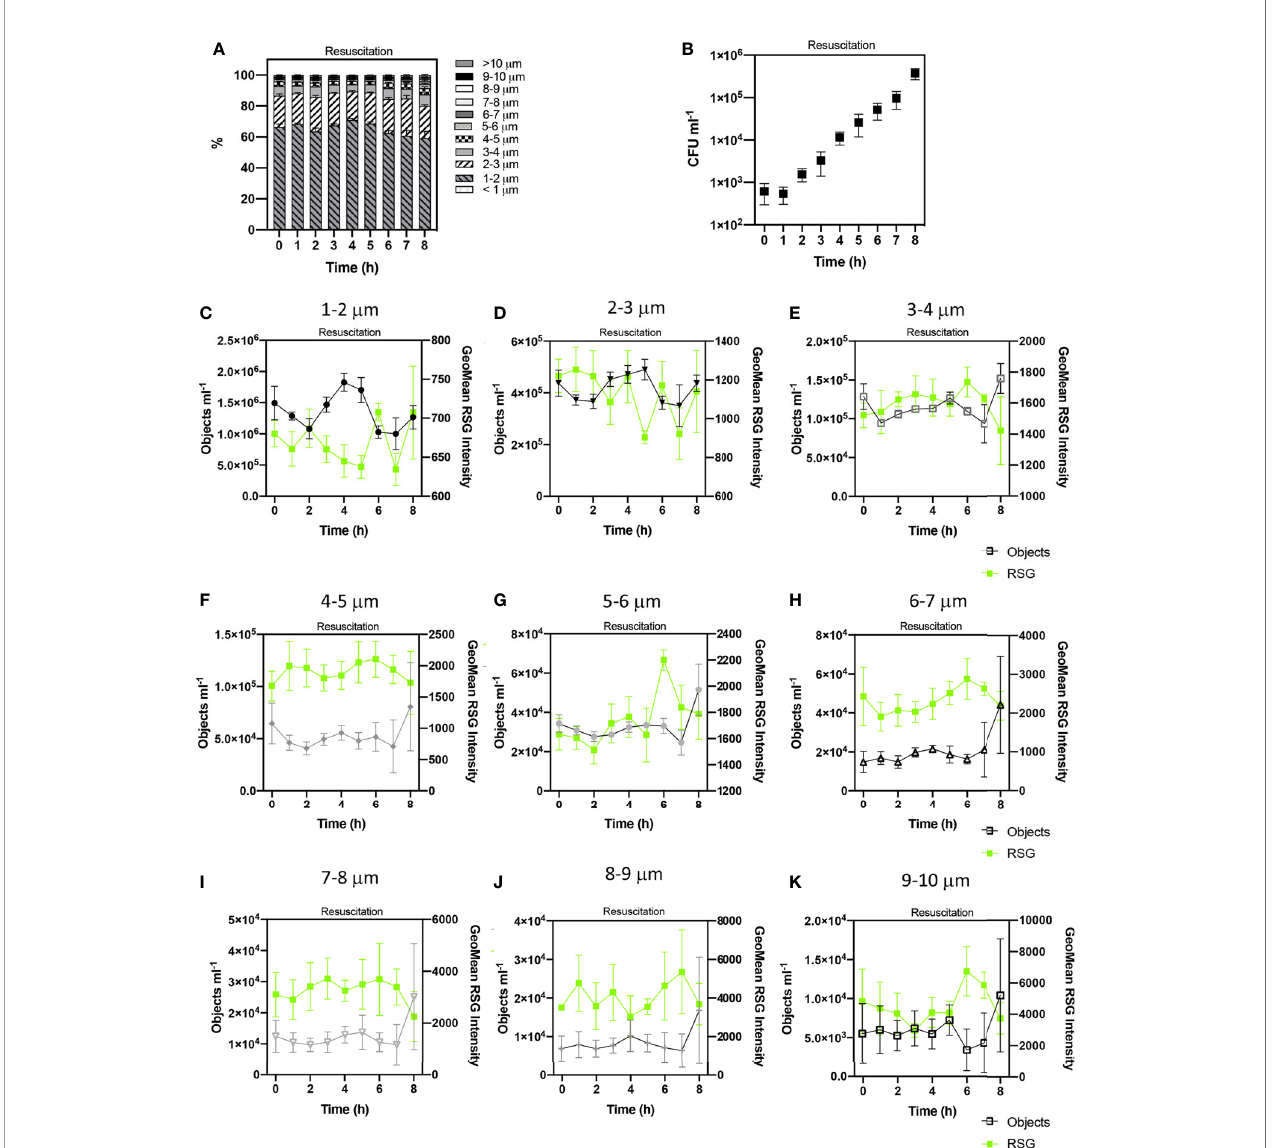
FIGURE 6 | Tracking the revival of E. coli persister cells after antibiotic exposure. Proportions of cell sizes within the persister group (PG) (A) . The growth of viable cells was monitored via colony forming unit (CFU) counts (B) . Concentrations of cell sizes (at 1 µm cell length intervals) and Geometric mean intensity of RSG for these size intervals over 8 h of resuscitation (C – K) . Changes in these concentrations re fl ect cell growth and therefore the determination of persister cells. n = 5; error bars represent standard error of the